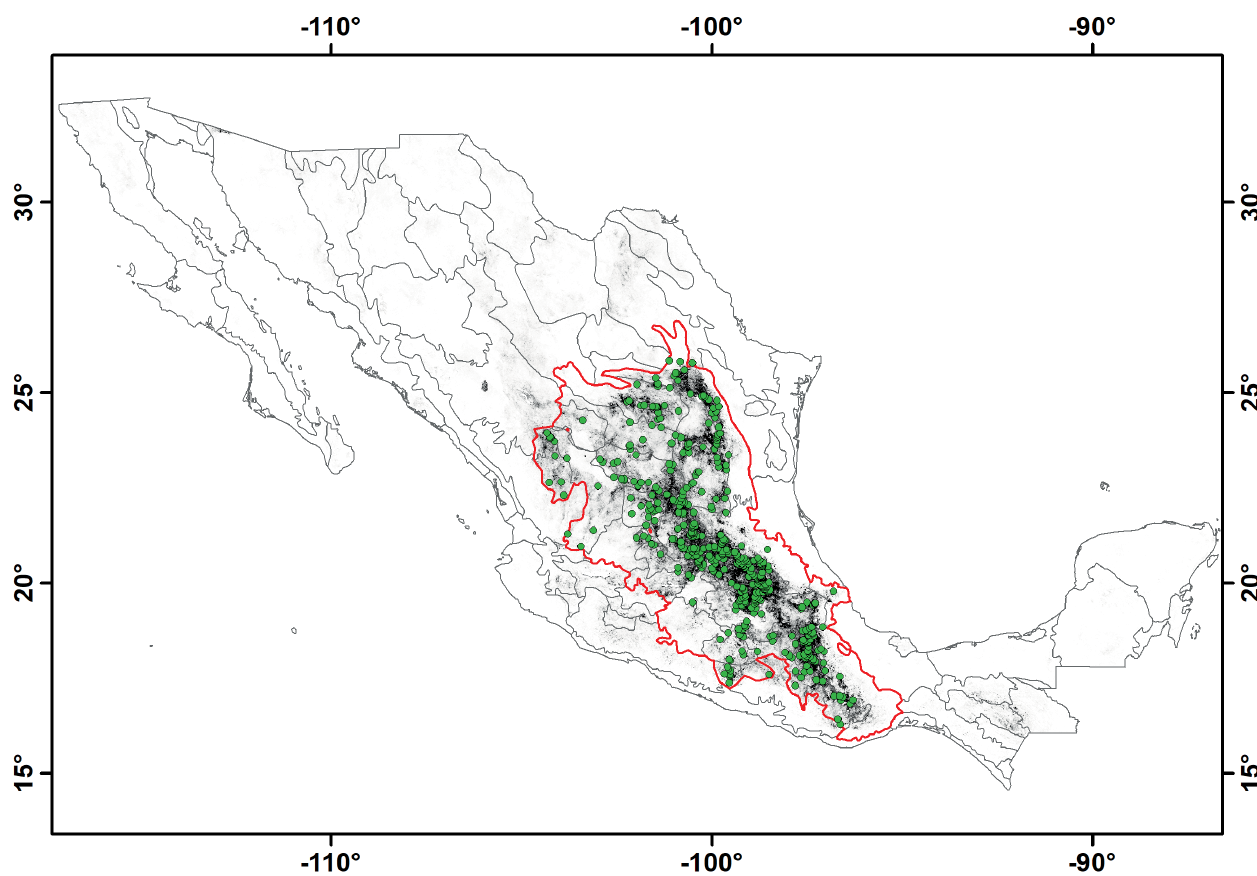
Figure 1 – Map of the physiographic provinces of Mexico on which the study area (area M, Soberón & Peterson 2005) is delineated with a red line. The ecological niche models were constructed using this area. The occurrences of all records of the eight Zaluzania species studied are indicated with green circles. Map created using ArcMap 9.3 (https://www.arcgis.com). © Esri and its licensors, all rights reserved. This image is not distributed under the terms of the Creative Commons license of this publication. For permission to reuse, please contact the rights